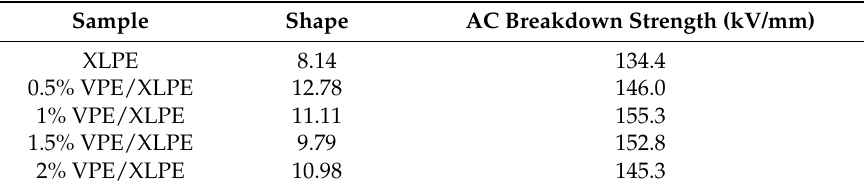
Figure 3. ( a ) breakdown strength Weibull curve of VPE/XLPE; ( b ) electrical tree initiation voltage of XLPE and composite; ( c ) electrical tree microscopic morphology of XLPE; ( d ) electrical tree microscopic morphology of VPE /XLPE. Table 1. Weibull distribution parameters of AC breakdown strength.